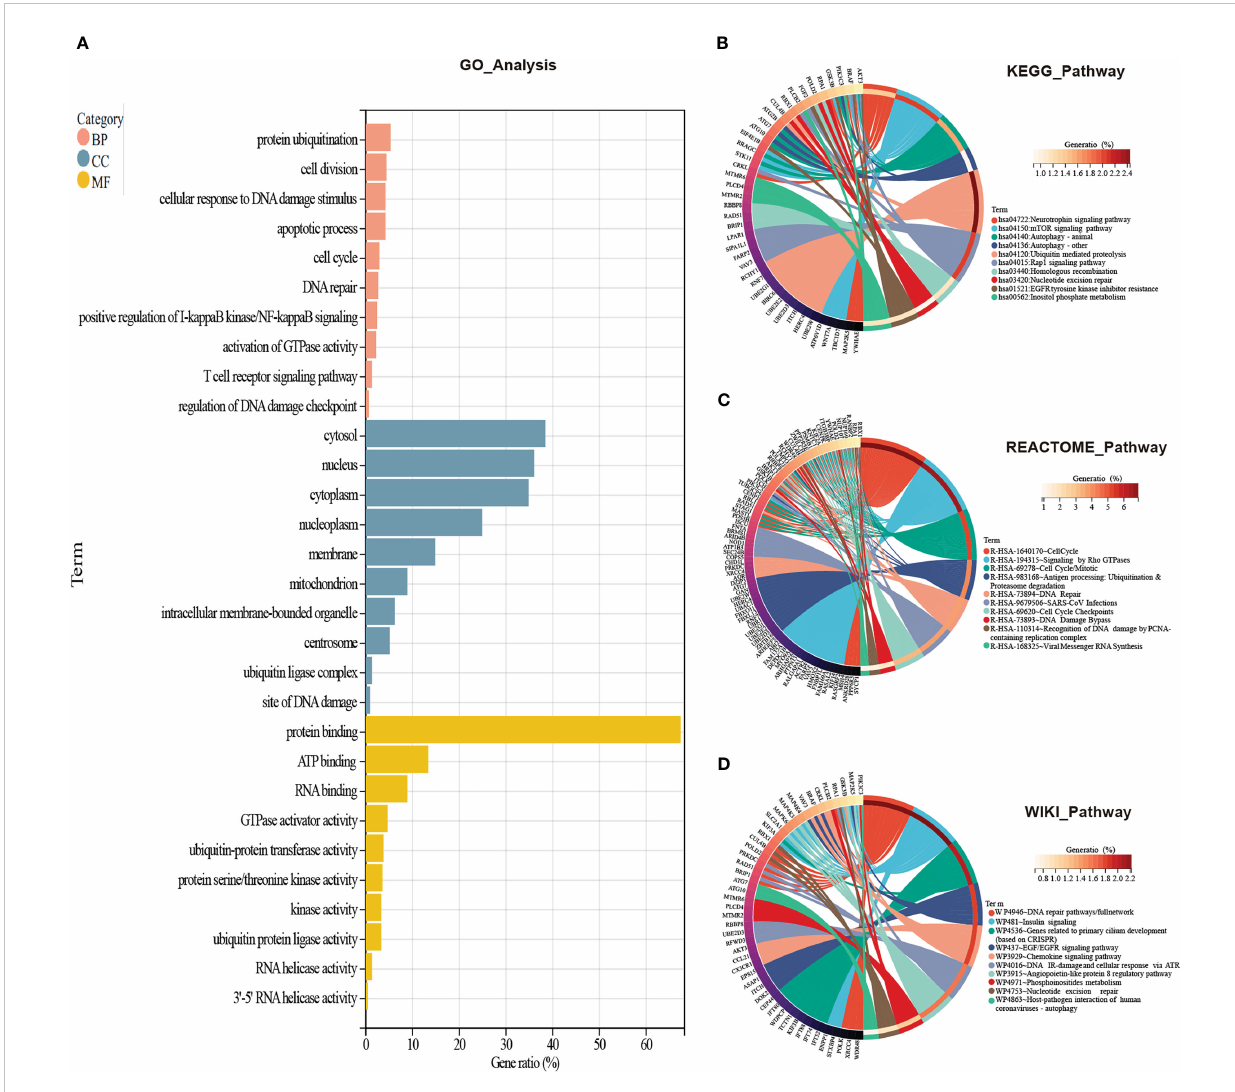
FIGURE 3 GO and pathway enrichment analysis of CORGs. (A) GO enrichment analysis of CORGs. Pathway enrichment analysis of CORGs in the KEGG database (B) , REACTOME database (C) , and WikiPathways database (D) . CORGs, COVID-19-related differentially expressed genes; GO, Gene Ontology; BP, biological process; CC, cellular component; MF, molecular